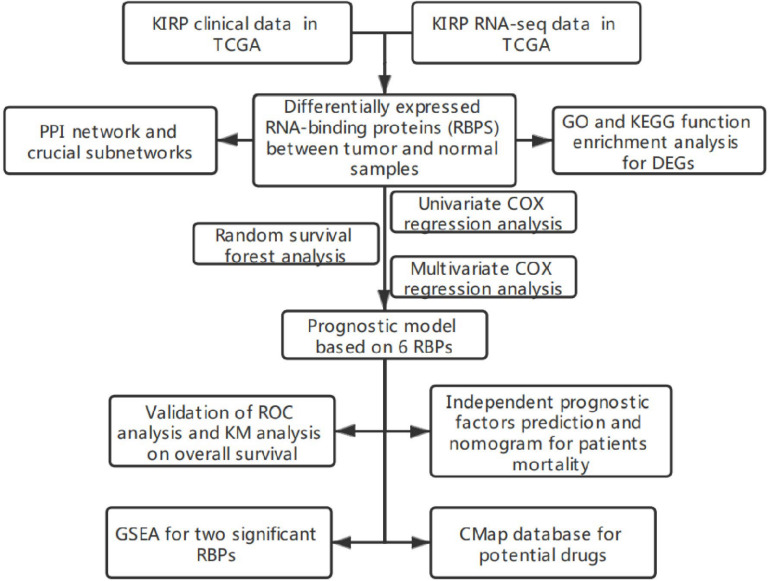
Flowchart of analyzation on RBPs in renal papillary cell carcinoma (pRCC).